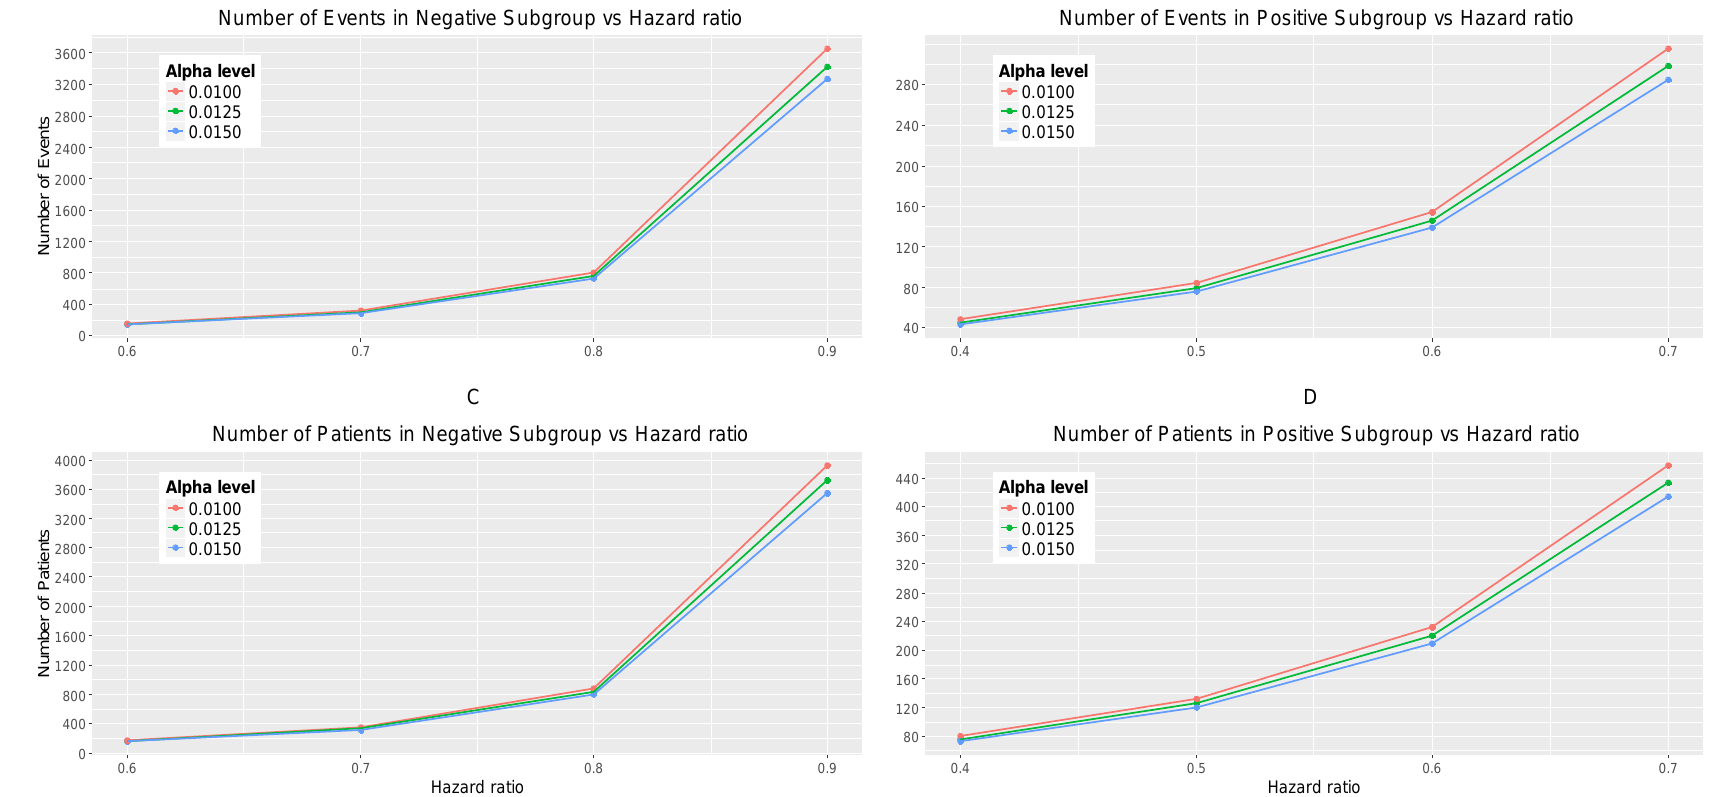
Figure 3. ( A , B ) represent the required number of events and ( C , D ) represent the required number of patients which achieve 80% power versus the hazard ratio in each of the three scenarios of significance levels for each biomarker-defined subgroup separately. ( A , C ) correspond to the biomarker-negative subgroup and the following significance levels: (i) 𝑎 − = 0.0125 , (ii) 𝑎 − = 0.015 , and (iii) 𝑎 − = 0.010 . ( B , D ) correspond to the biomarker-positive subgroup and the following significance levels: (i) 𝑎 + = 0.0125 , (ii) 𝑎 + = 0.010 , and (iii) 𝑎 + = 0.015 .